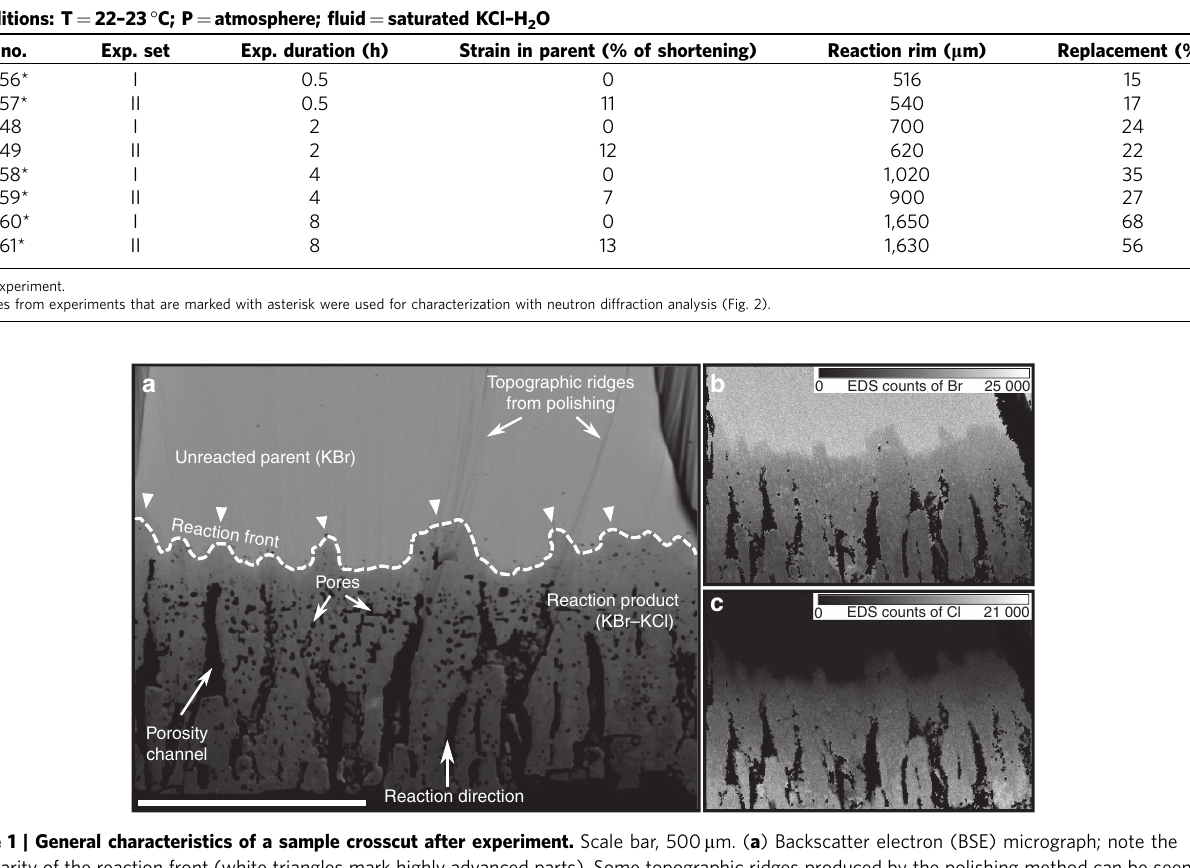
Table 1 | Samples and experimental conditions.